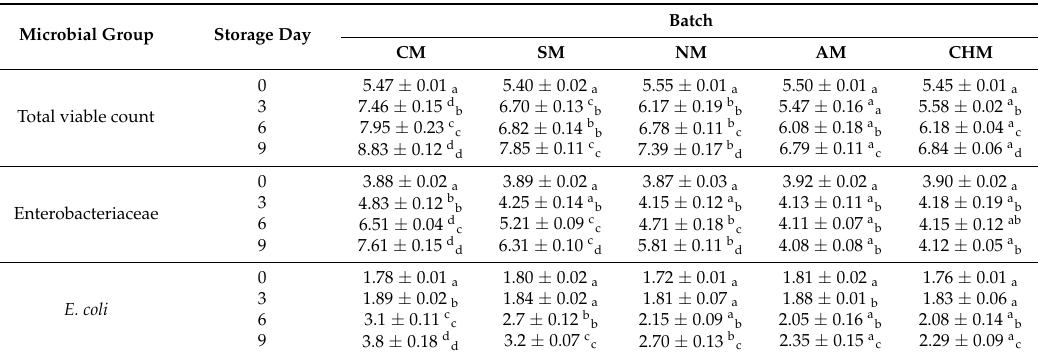
Table 2. Microbial changes in minced meat contaminated with Salmonella CECT 4594 in the five different batches elaborated during storage time. Results are expressed as log cfu/g. Different superscript letters in the same row indicate significant differences ( p < 0.05). Different subscript letters in the same column and microbial group indicate significant differences ( p < 0.05).